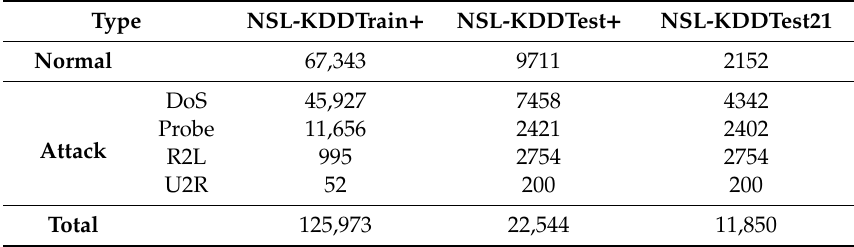
Table 1. Distribution of di ff erent data